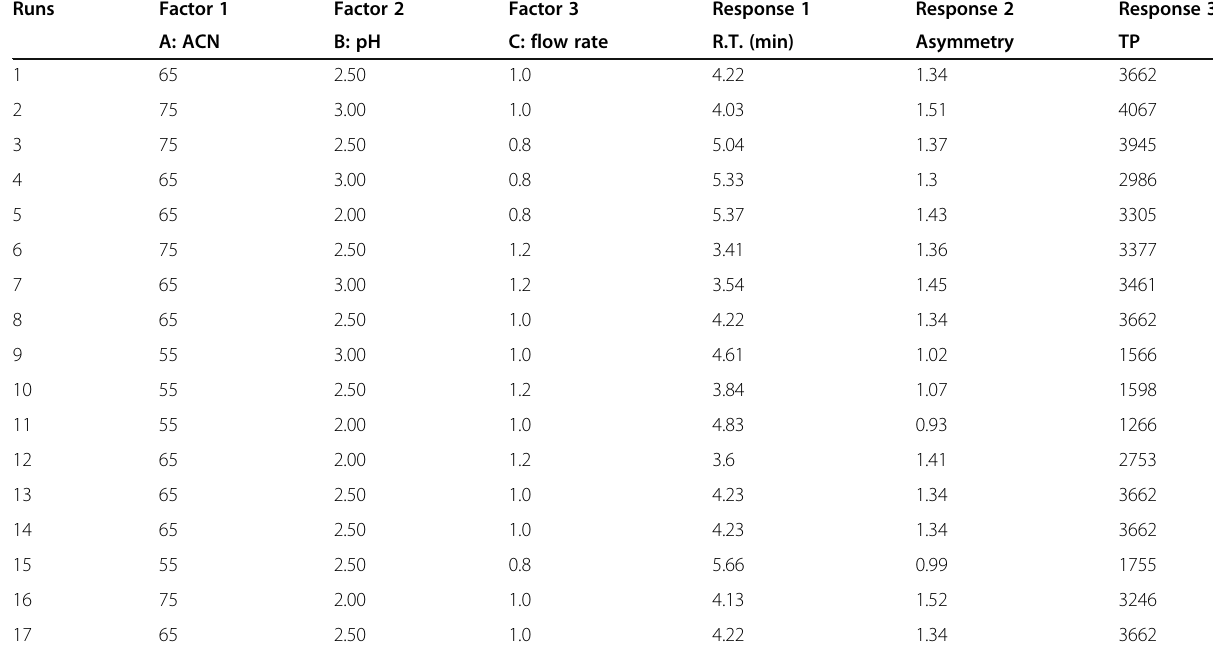
Table 1 3 3 Box-Behnken full factorial design of DOE Runs